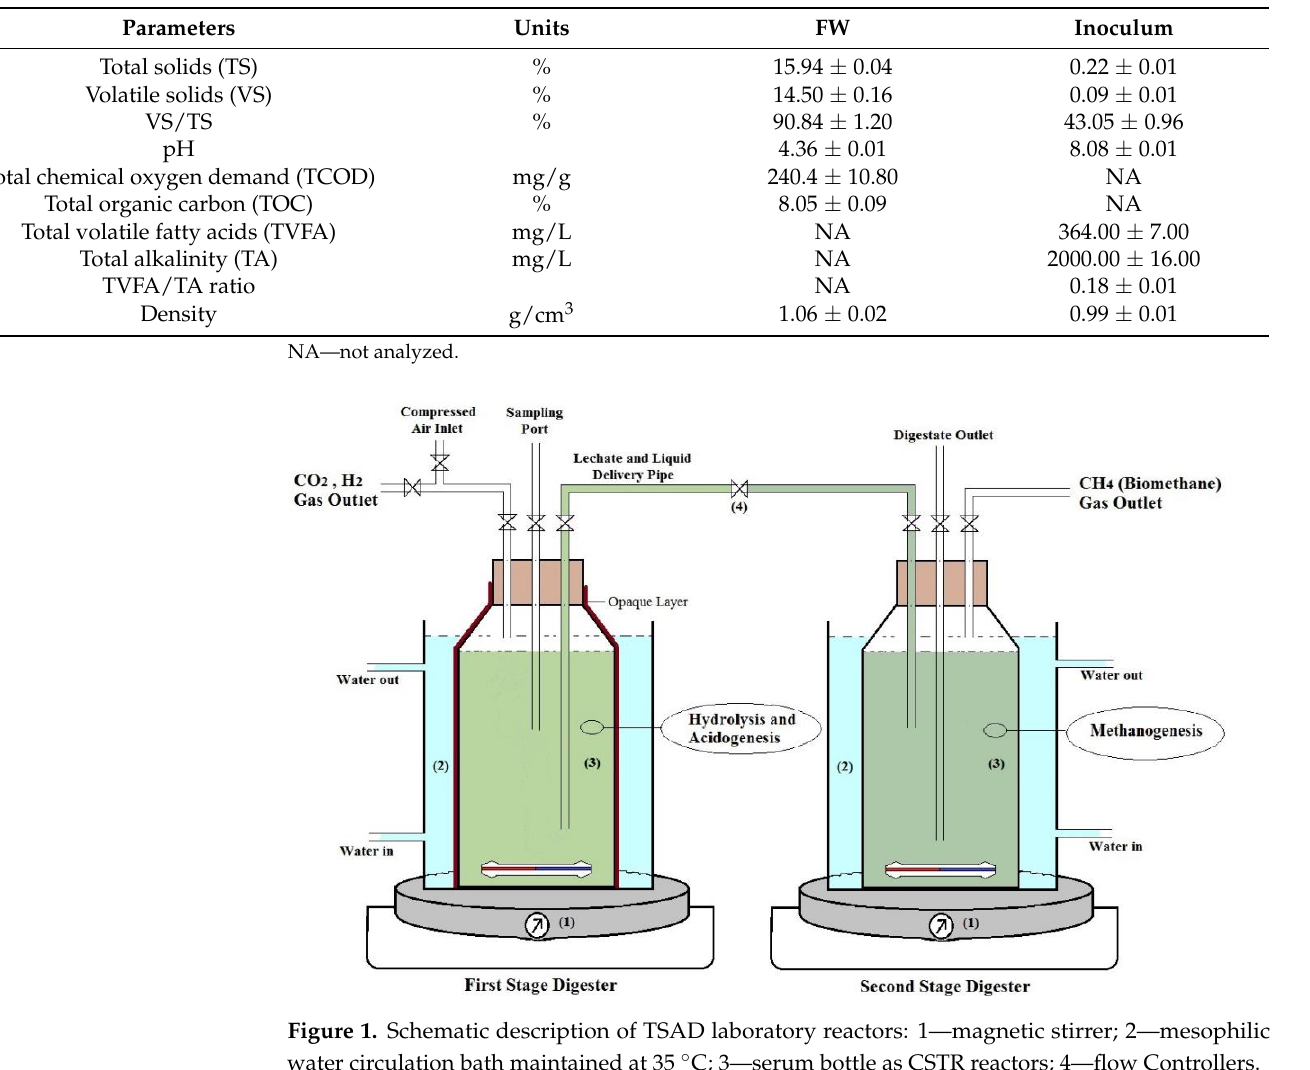
Table 1. Characteristics of the FW and inoculum used in the study.